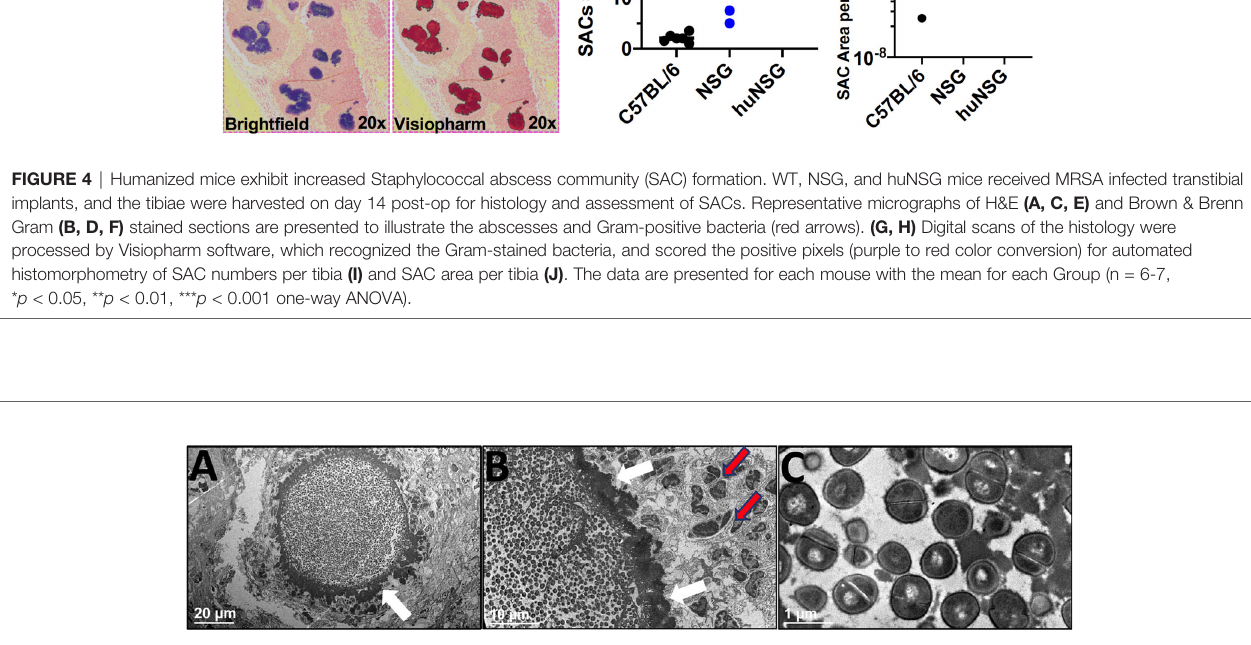
FIGURE 5 | Ultrastructural assessment of Staphylococcal abscess communities (SACs) in humanized mice. HuNSG mice were subjected to MRSA transtibial infection and tibiae were harvested 14 days post-op, formalin- fi xed, and decalci fi ed for TEM processing. These paraf fi n-embedded tibiae samples were reprocessed into epoxy resin for transmission electron microscopy. A representative SAC in the bone marrow cavity is shown in (A) x1200 and (B) x3000 to illustrate the bacteria within the electron dense pseudocapsule (white arrows), and adjacent immune cells (red arrows) that are unable to penetrate the SAC. (C) High magni fi cation of S. aureus bacteria within the SAC (x